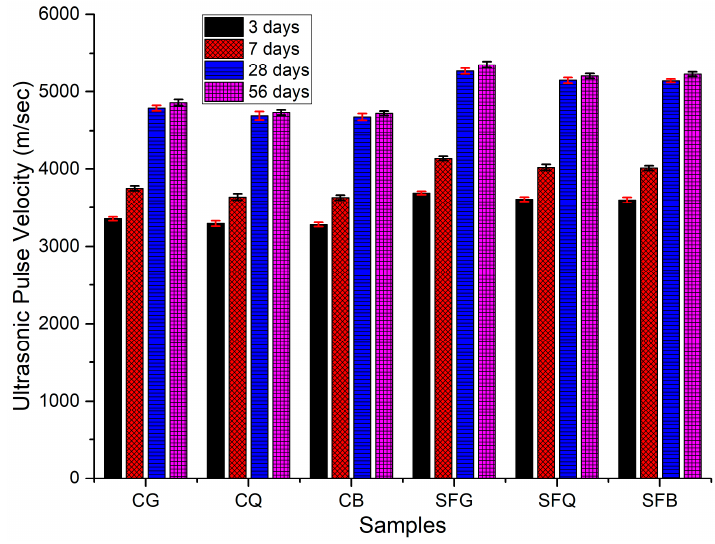
Figure 3. Ultrasonic pulse velocity test results.